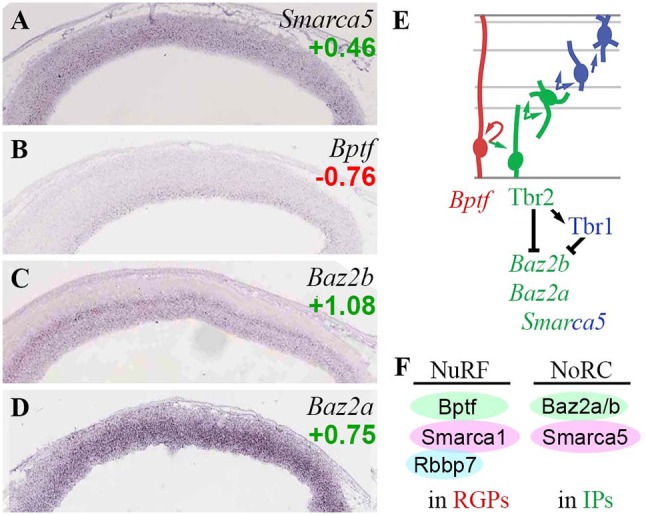
ISWI chromatin remodeling complexes. (A–D) Expression of indicated genes. The bilaminar expression of Baz2b (C) in VZ and SVZ is typical of aIP- and bIP-specific genes (Kawaguchi et al., 2008). ISH: Genepaint. Scale bar: 100 μm. (E) Gene expression and regulation. Although Baz2b
(C) is an IP marker, it was directly repressed by Tbr2 and Tbr1 (Supplementary Tables S2, S4). (F) NuRF complexes are enriched in RGPs, and NoRC complexes in IPs.